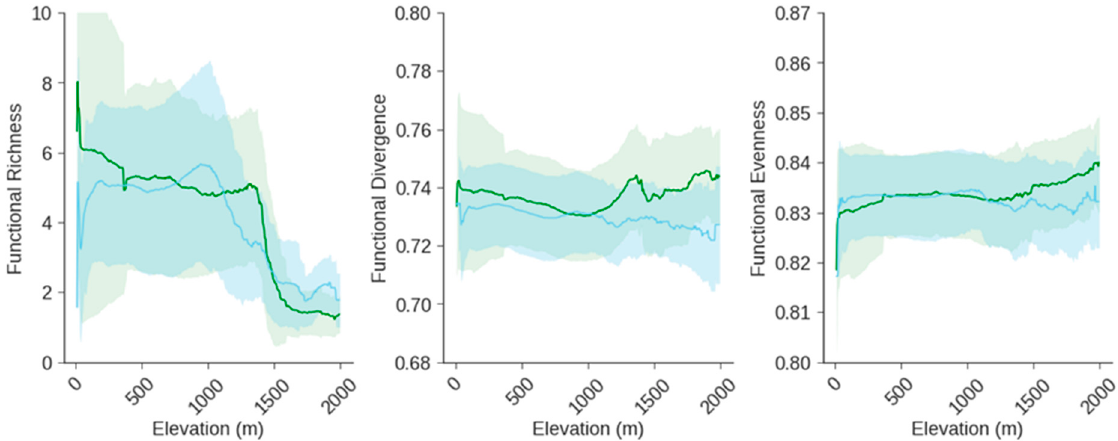
Figure A4 . Variation of functional diversity metrics along the average elevation of the plot. Green represents intact forests and blue indicates logged forests. Oil palm plantations were only found below 500 m ASL.